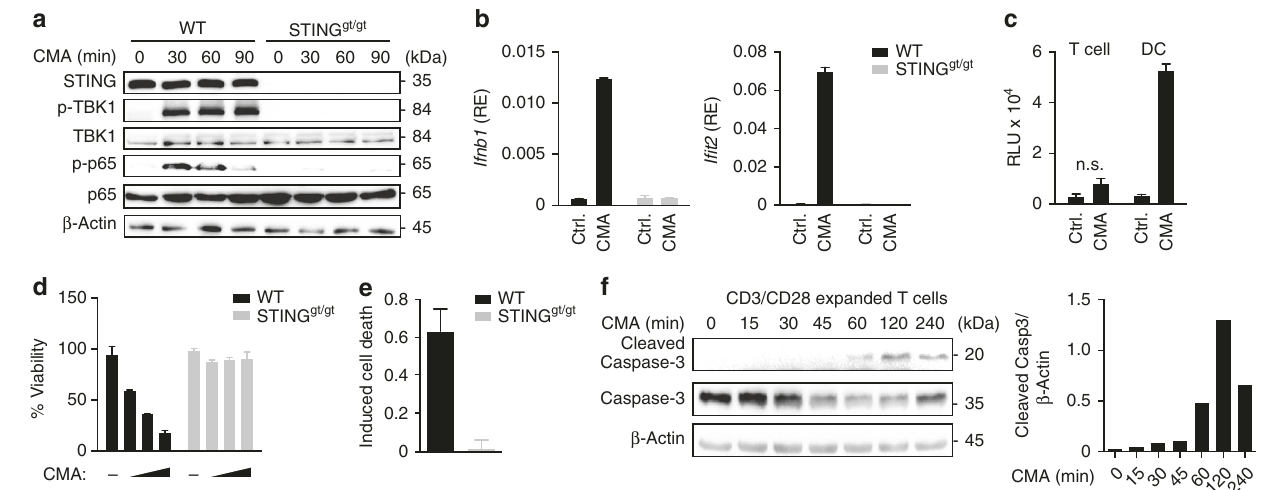
Fig. 1 STING activation induces apoptosis in T cells. a CD4 + T cells from wild-type (WT) or STING gt/gt mice were treated with DMSO or 10- carboxymethyl-9-acridanone (CMA) for the indicated times and phosphorylation of TBK1 and NF- κ B (p65) was assessed by immunoblot. b CD4 + T cells from WT or STING gt/gt mice were treated with DMSO or CMA for 4 h and abundance of mRNAs of the indicated genes was measured by RT-qPCR. c Supernatants from CD4 + T cells or dendritic cells (DC) treated with DMSO or CMA were collected after 16 h. A bioassay was used to measure the production of type I IFNs (RLU relative light units). d , e CD4 + T cells from WT and STING gt/gt mice were treated with DMSO or CMA. After 16 h cell viability d and percentage of apoptotic cells e , assessed by Annexin V staining, were determined. f WT CD4 + T cells were stimulated with CMA for the indicated times and caspases-3 cleavage was assessed by immunoblot. Quanti fi cation of cleaved Caspase-3 relative to β -Actin levels is shown on the right panel. Data are representative of n = 3 ( a , f ) independent experiments or mean and s.d. of technical replicates ( n = 2) of one representative experiment out of n = 3 ( b , d , e ) or n = 2 ( c ) independent experiments are shown. Unprocessed original blots are shown in Supplementary Fig.